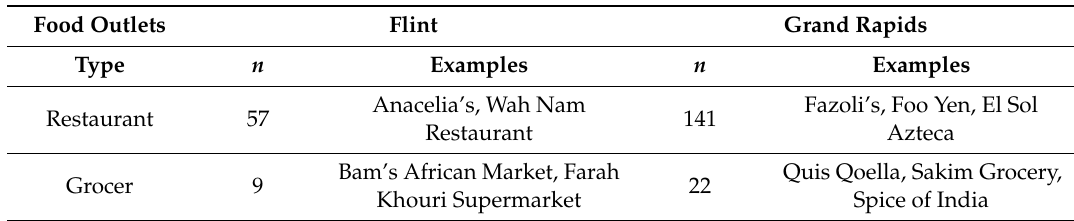
Table 2. Ethnic food outlets in each